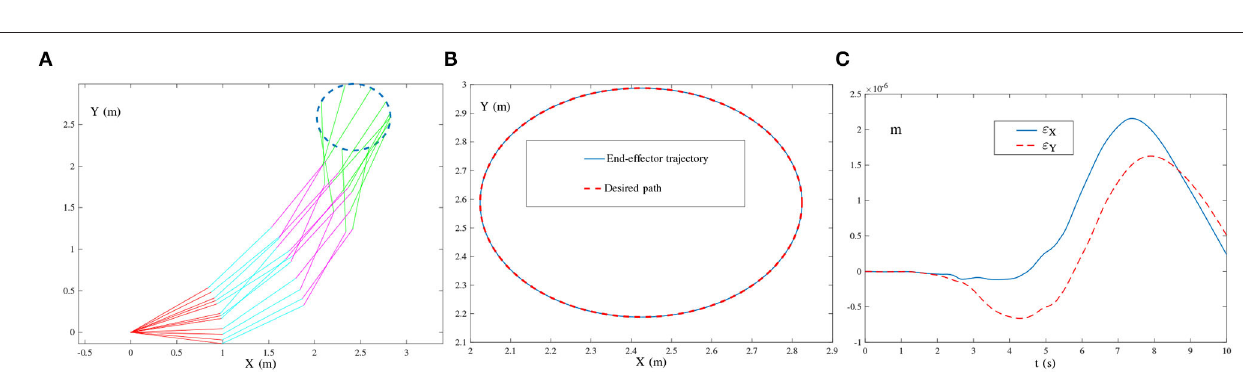
multiple-harmonic